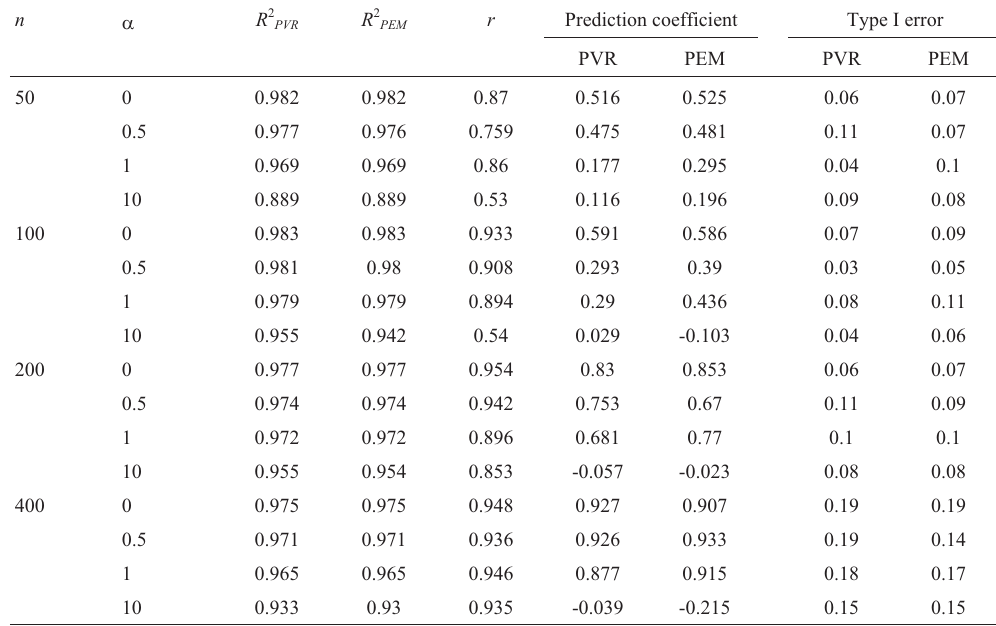
Table 1 - Comparison of PEM and PVR for phylogenies with different sample sizes (n), simulating trait evolution with distinct restraining forces of an O-Uprocess( (cid:2) ,inwhich (cid:2) =0indicatesBrownianmotion).Thecomparisonincludesthephylogeneticsignalestimatedbythetwomethods( R 2 ),thecor- relation between model residuals (r), the prediction coefficient used in phylogenetic imputation and the Type I errors of correlated evolution. n (cid:2) R 2 PVR R 2 PEM r Prediction